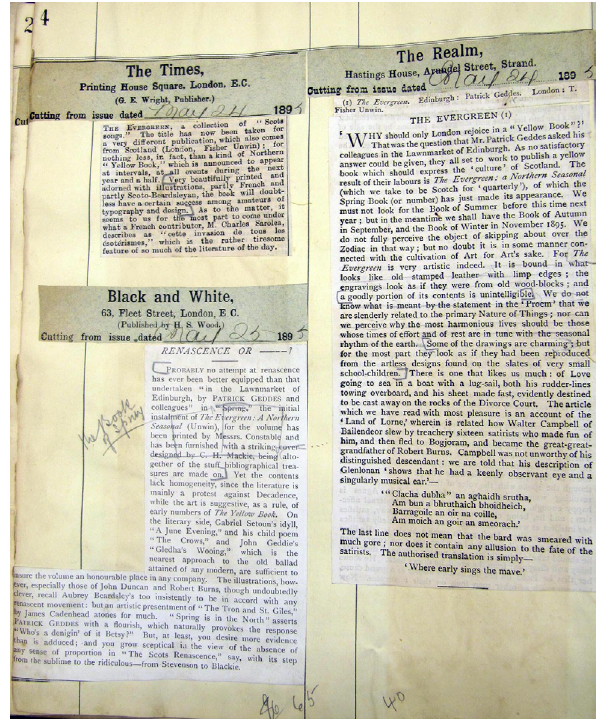
Fig. 10 ‘Evergreen Cuttings Book’, SUA T-GED 8/1/8, p. 4, Glasgow, Strathclyde